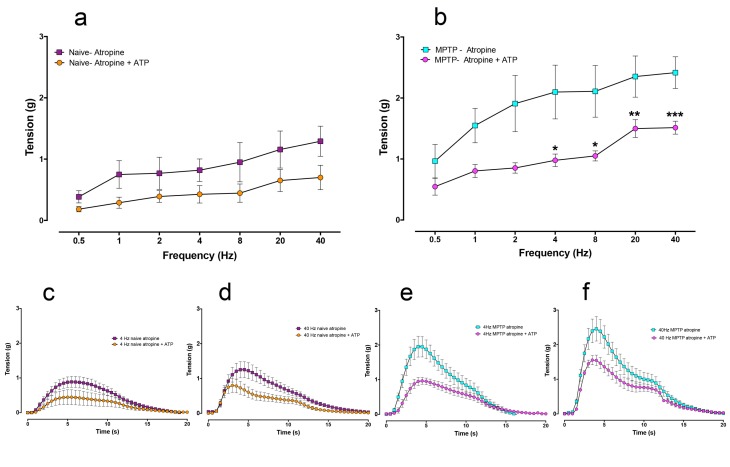
Frequency dependent increase in the atropine-resistant contractile response of the isolated detrusor strips in response to trains of 20 pulses at frequencies ranging from 0.25 to 40 Hz in the absence or following ATP-desensitisation (x3, 1mM ATP).In the detrusor strips from drug naïve animals (a, c, d), ATP-desensitisation non-significantly inhibited peak contractile responses throughout the range of frequencies used (a) whereas in the strips obtained from MPTP-treated animals (b), the contractions were significantly decreased at frequencies beyond 4Hz. Time course of EFS-evoked contractile responses of detrusor strips from normal detrusor strips at 4 Hz (c) and 40 Hz (d) shows a greater inhibition of the primary peak at 4 and 40 Hz in the tissues obtained from MPTP-treated animals (e and f) compared to tissues from normal animals (c and d). Each data point represents mean ± sem (n = 4) * P<0.05, **P<0.005, ***P<0.001.